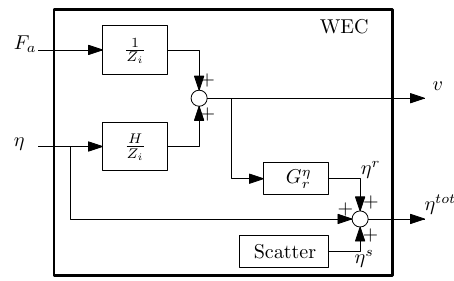
Figure 8. Block diagram of the system when including effects of radiated and scattered waves on the surface elevation measurements. The measured surface elevation η tot includes terms due to the scattered waves η s and radiated waves η r , in addition to the incoming wave train η